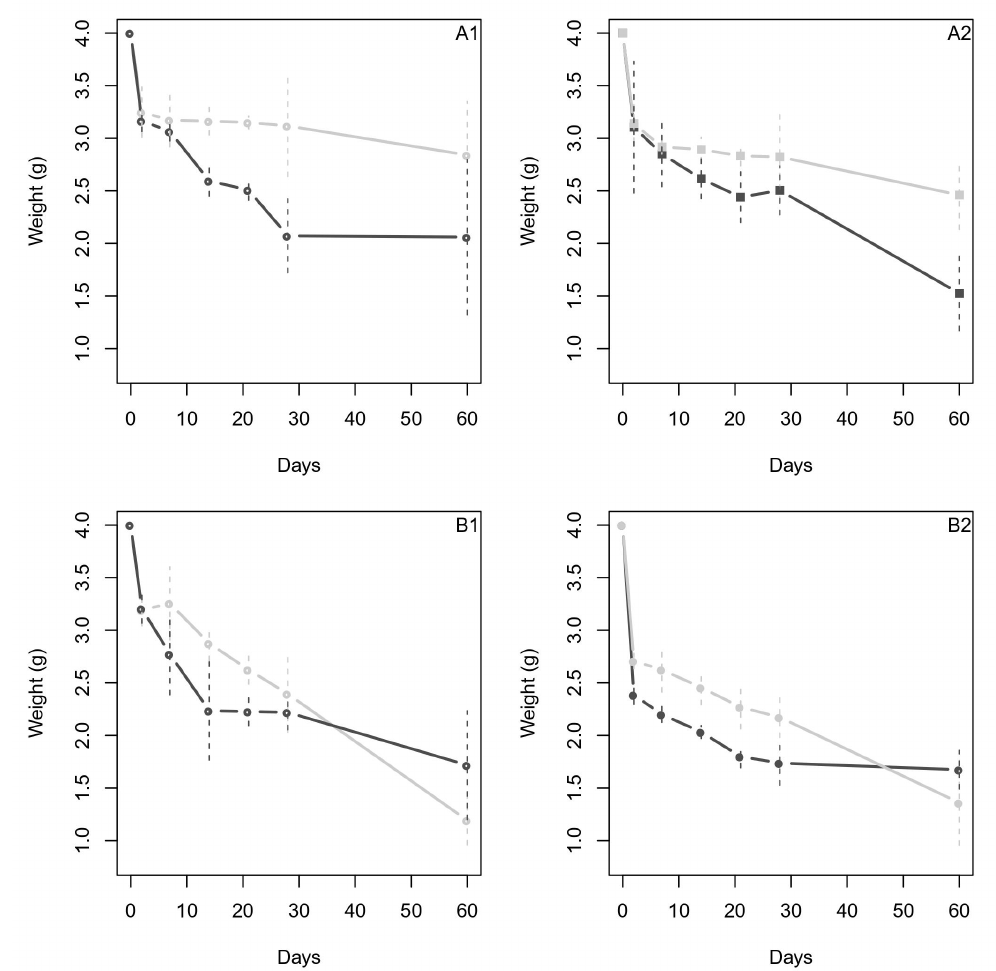
Figure 1. Mean (circles/squares) and standard deviation (vertical line segments) of the remaining weight observed over time. Panels A: experiment involving the species E. grandis (A1, open circles) and L. molleoides (A2, squares). Panels B: experiment involving the species E. grandis (B1, open circles) and M. aquifolium (B2, closed circles). In all panels, light gray denotes weights observed during the dry season and dark gray denotes weights observed during the rainy